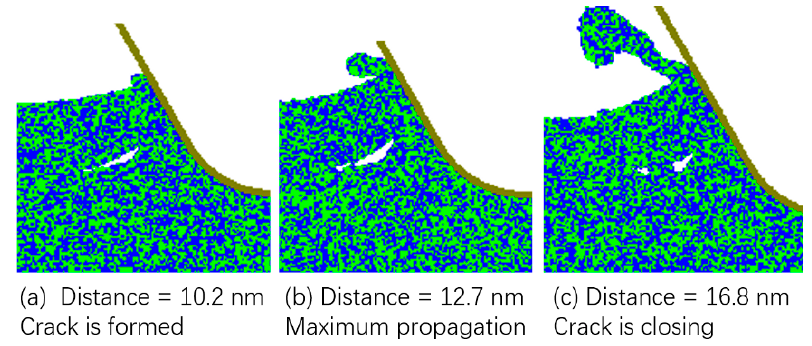
Figure 3. Crack formation and closing under t uc of 25 nm.